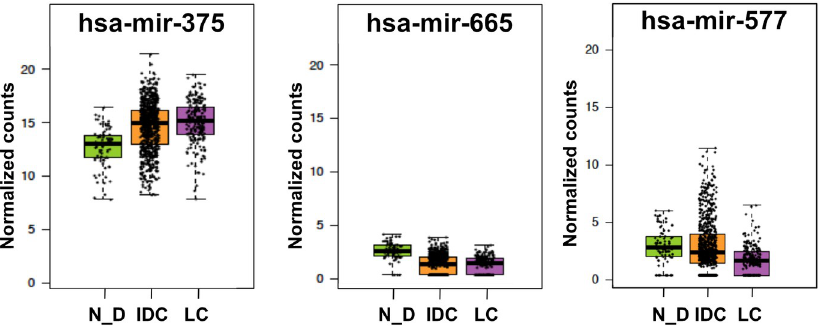
Fig 6. Selected DEMs that are functionally validated to target DNA repair DEGs. Boxplots represent normalized counts in normal_ductal ‘N_D’ (Green), IDC (Orange) and LC (Purple).